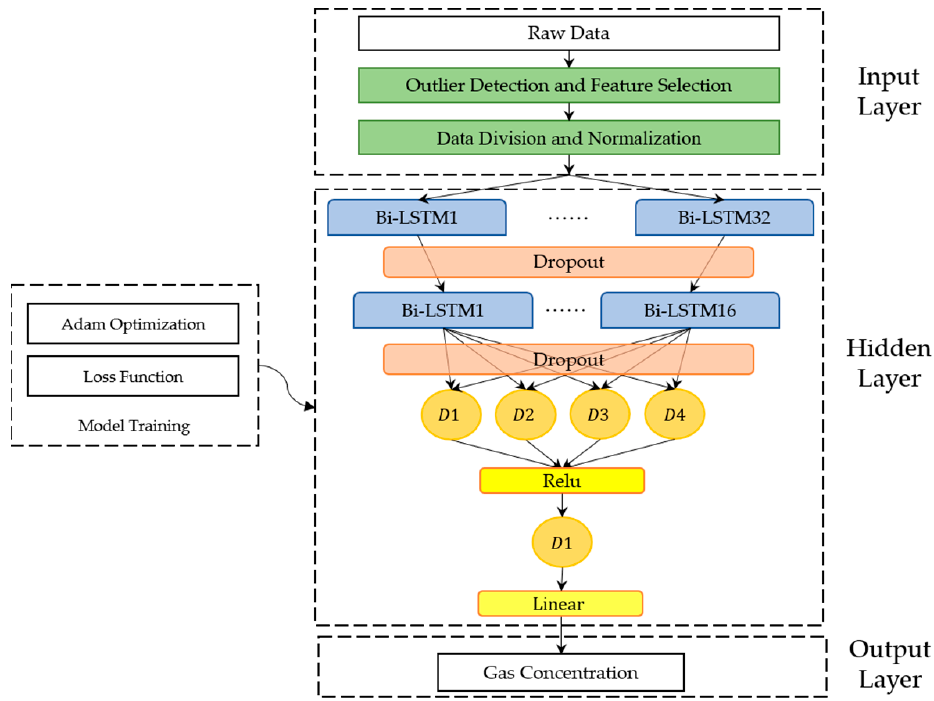
Figure 9. Structure diagram of the gas model.